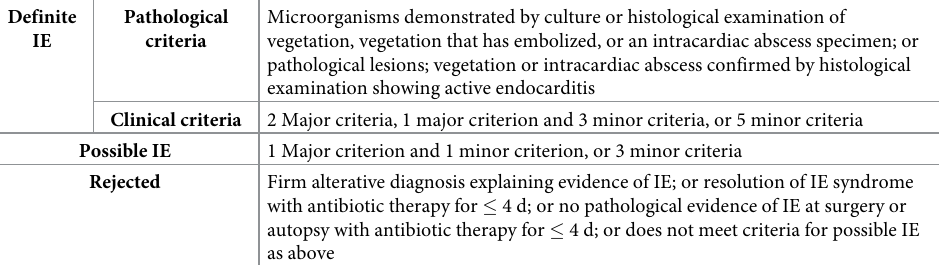
Table 1. Definitions of definite, possible and rejected infective endocarditis